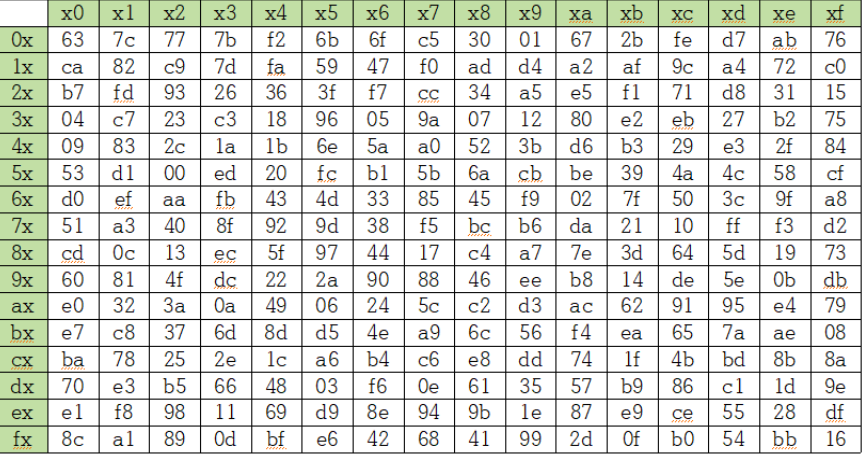
Figure 4. S-box table.